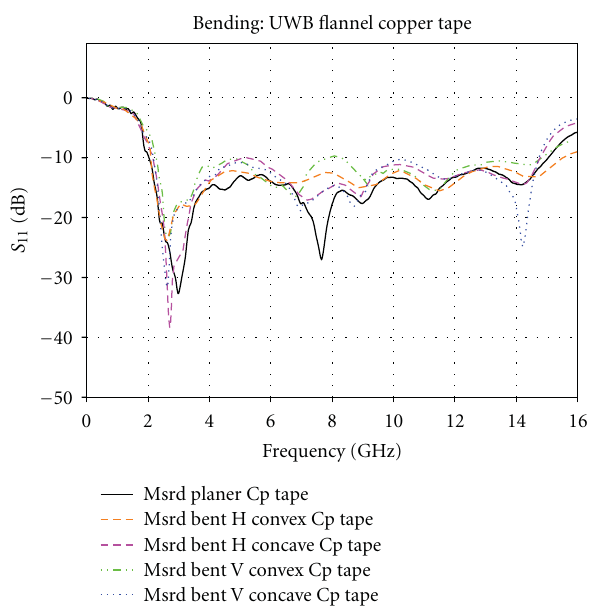
Figure 9: Measured ( | S 11 | ) bending results of UWB antenna prototype using copper conducting